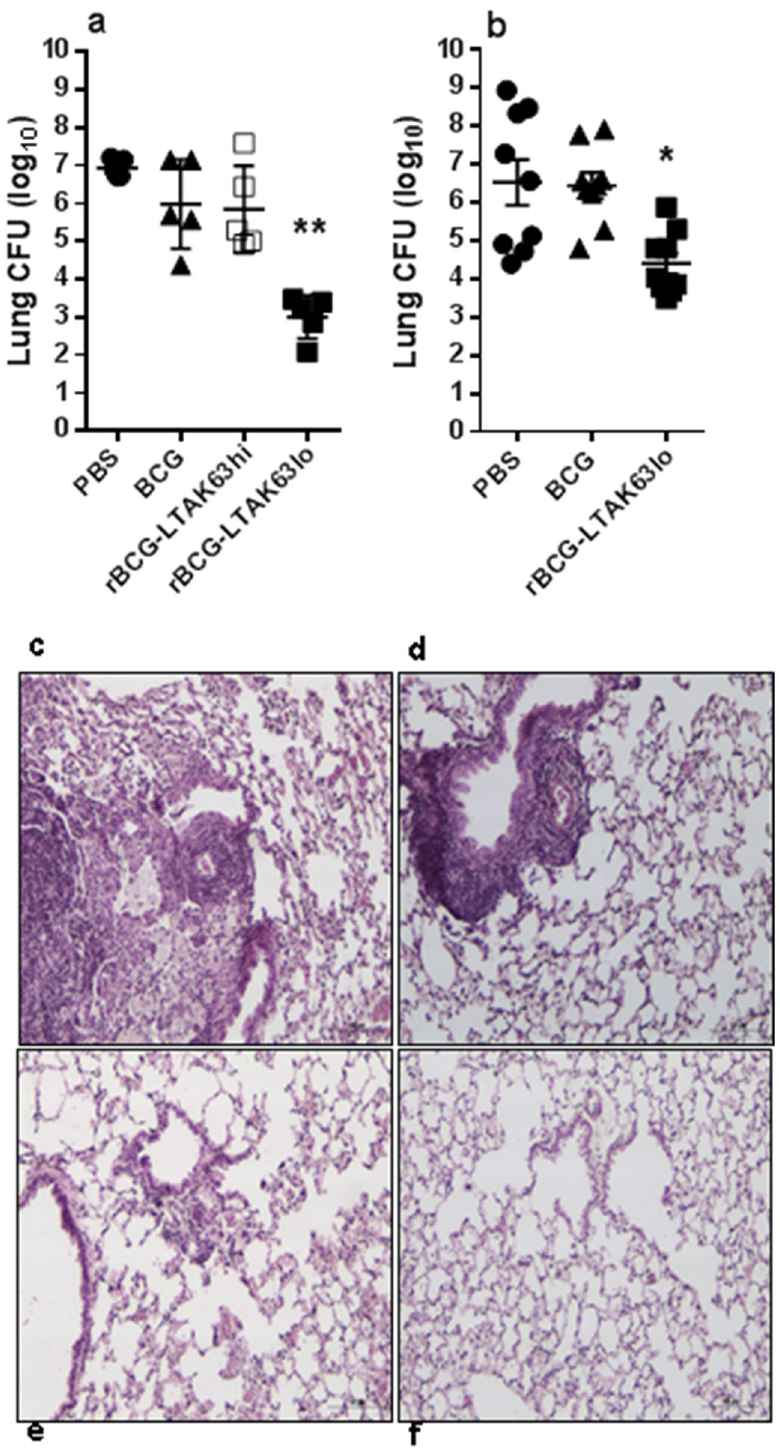
Figure 3. Protection against challenge with Mtb induced by immunization with rBCG-LTAK63 lo . BALB/c mice were immunized with BCG, rBCG-LTAK63 hi or rBCG-LTAK63 lo (1 × 10 6 CFU) and a group received PBS; they were challenged intratracheally 12 weeks later with a dose of Mtb H37Rv (1 × 10 5 CFU). Bacteria were recovered from the lungs 30 days after challenge. ( a ) Experiment 1 (n = 5 animals) and ( b ) Experiment 2 (n = 8–10 animals). Bars are mean ± S.D. ( * ) Differences were considered statistically significant when P ≤ 0.05 or ( ** ) P ≤ 0.01 as compared to the BCG group (one-way Anova). Histological analysis was performed on the lungs of challenged mice from Experiment 1: that received ( c ) PBS, ( d ) BCG, ( e ) rBCG-LTAK63 hi or ( f ) rBCG-LTAK63 lo and challenged with Mtb 90 days post immunization. Tissues were collected 30 days post challenge, sectioned, stained with H&E, and examined by optical microscopy. Bars indicate 100 µ m